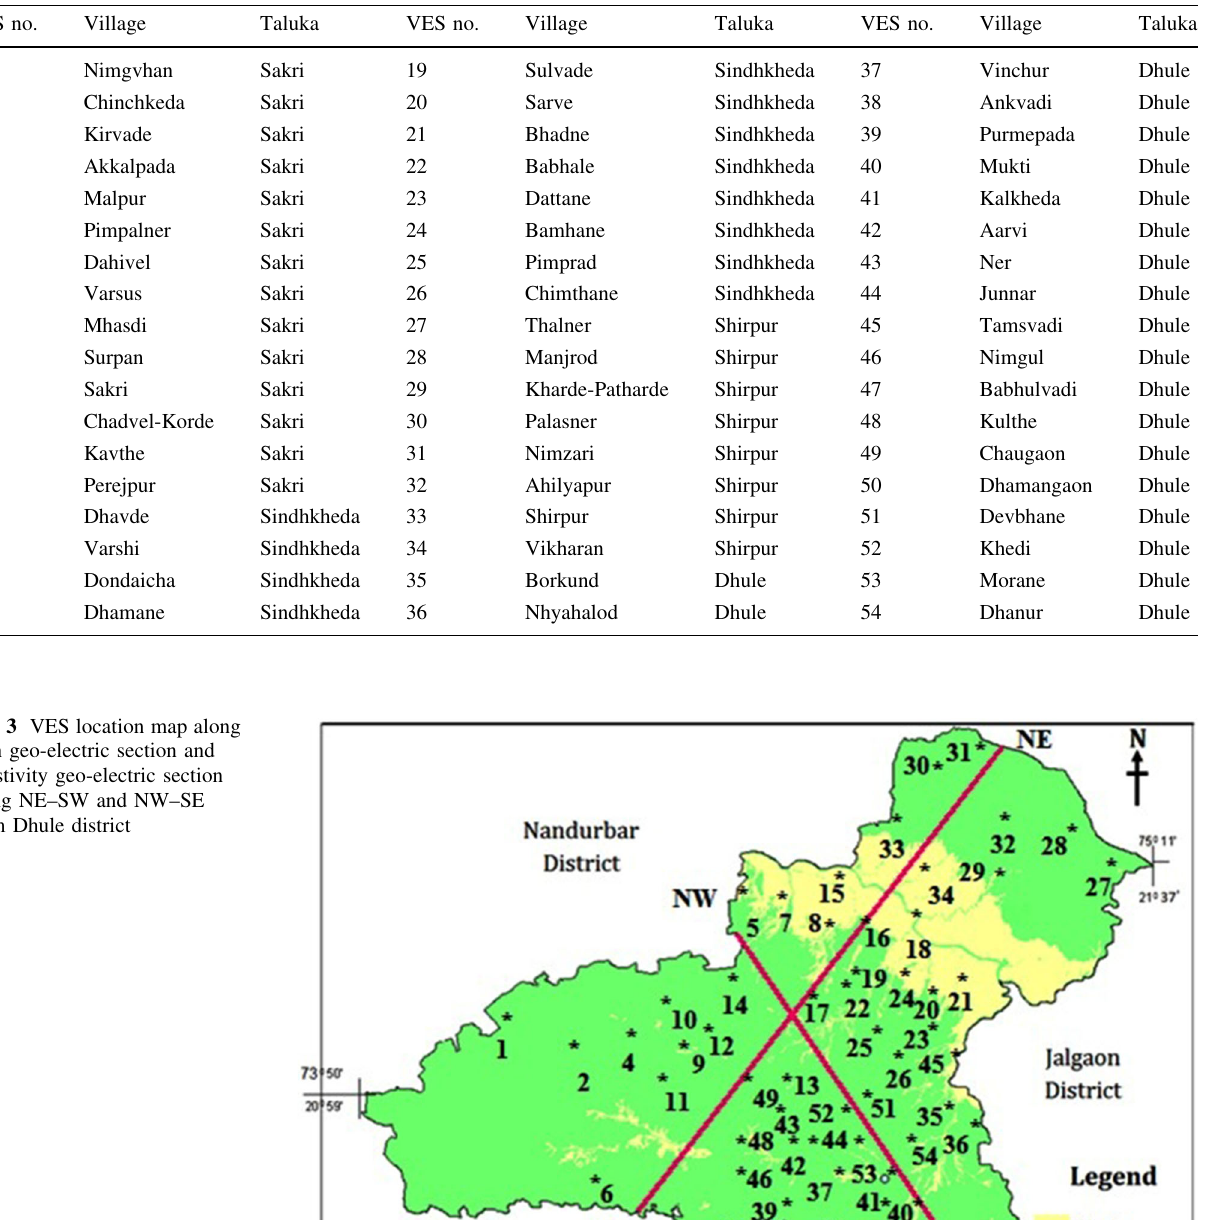
Table 1 VES locations in Dhule district, India VES